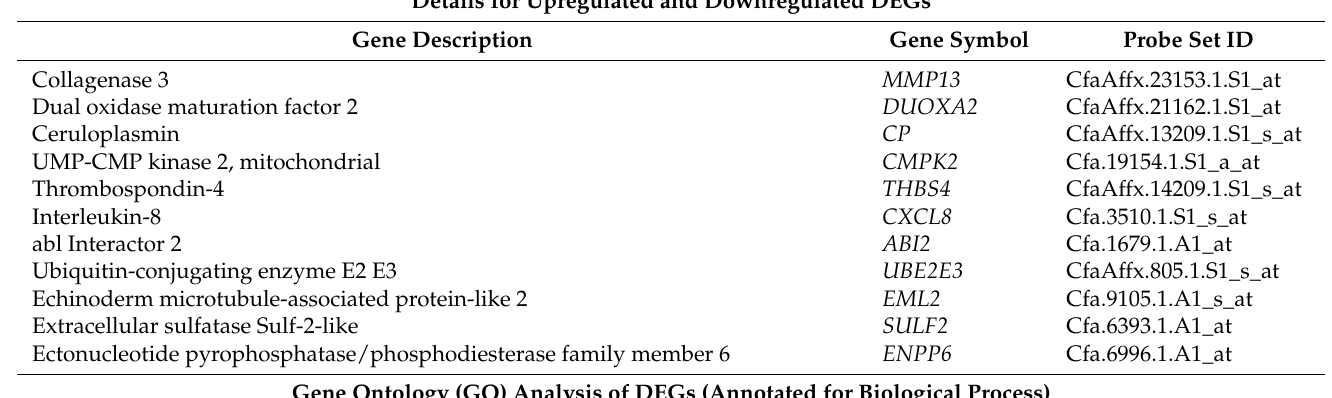
Table 6. The Gene Ontology (GO) analysis and details of the DEGs in the LPS treated IBD colonoids vs. the control IBD colonoids annotated for the biological process, molecular function, and cellular component categories. The percentages represent the number of genes in each functional